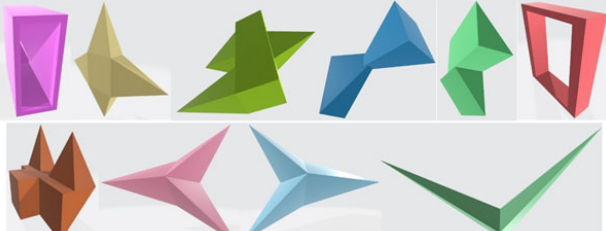
Fig. 8. Non-Convex Pieces (1 to 10 from left to right, from top to bottom) of the data set SGSPM04 from Stoyan et al. (2004)